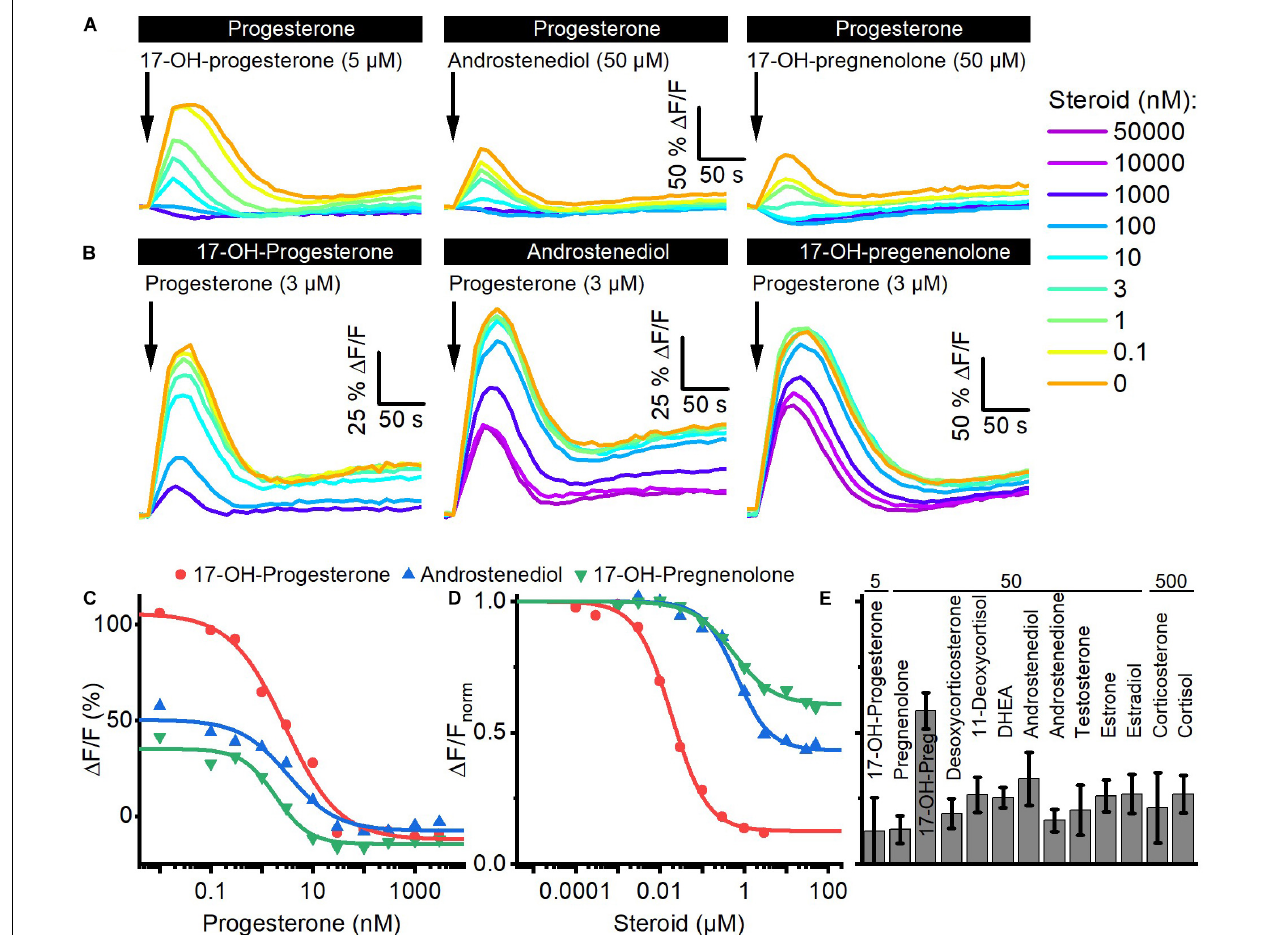
FIGURE 3 | Steroids compete for the same binding site to activate CatSper in human sperm. (A) Representative Ca 2 + signals evoked by a saturating concentration of 17-OH-progesterone (5 µ M), androstenediol (50 µ M), or 17-OH-pregnenolone (50 µ M) in sperm preincubated in different concentrations of progesterone. (B) Representative Ca 2 + signals evoked by a saturating concentration of progesterone (3 µ M) in sperm preincubated in different concentrations of 17-OH-progesterone, androstenediol, or 17-OH-pregnenolone. (C) Maximal amplitude of steroid-evoked Ca 2 + responses shown in (A) , plotted as a function of the (preincubated) progesterone concentration. (D) Maximal amplitude of the progesterone-evoked Ca 2 + responses shown in (B) , plotted as a function of the (preincubated) steroid concentration. (E) Mean ( ± SD) maximal amplitude of the Ca 2 + signal evoked by progesterone (3 µ M) in sperm preincubated in the indicated (in µ M) saturating concentration of the respective steroid ( n =